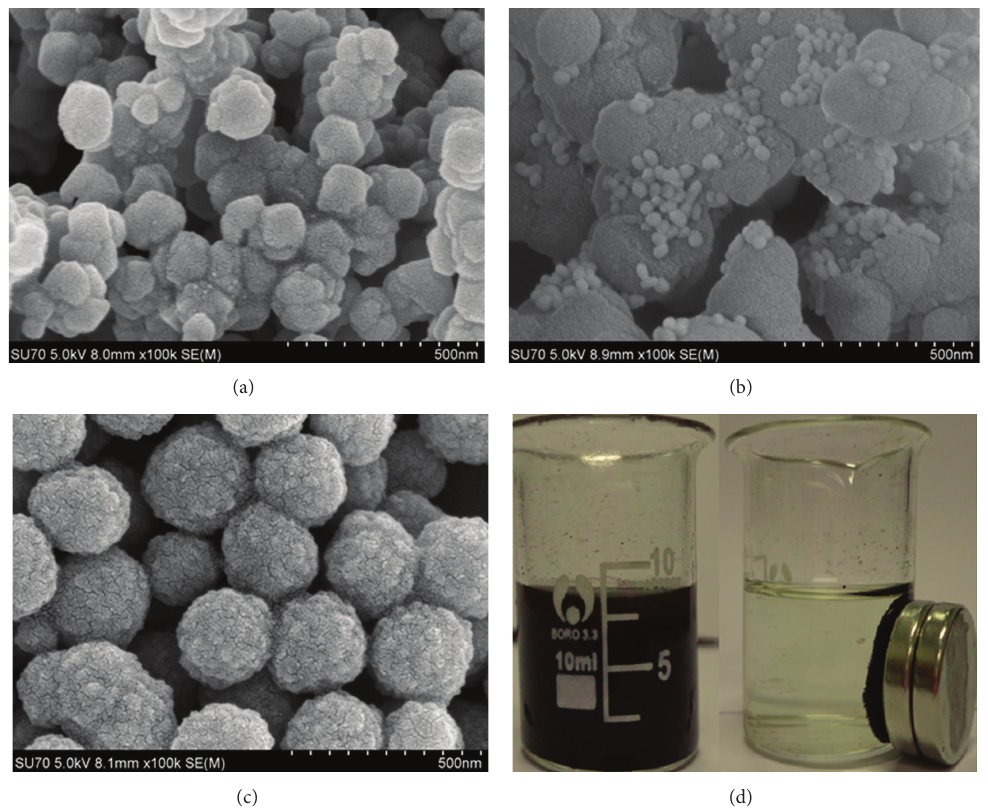
Figure 3: SEM images of (a) Fe 3 O 4 @SiO 2 , (b) Fe 3 O 4 @SiO 2 @Au, (c) Fe-Au MNPs-anti-CRP2/HRP signal tag, (d) c in absence (right) and presence (left) of magnetic